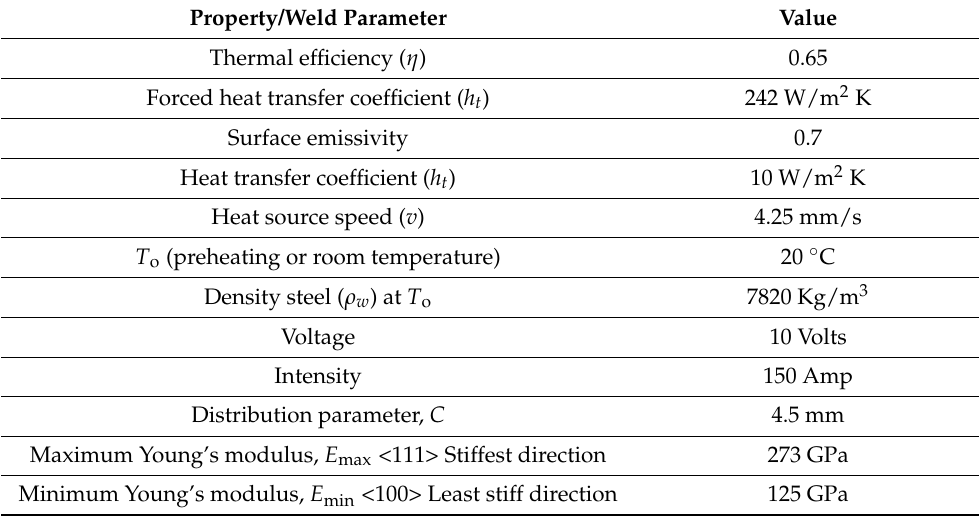
Table 1. Data used in the FE analysis.